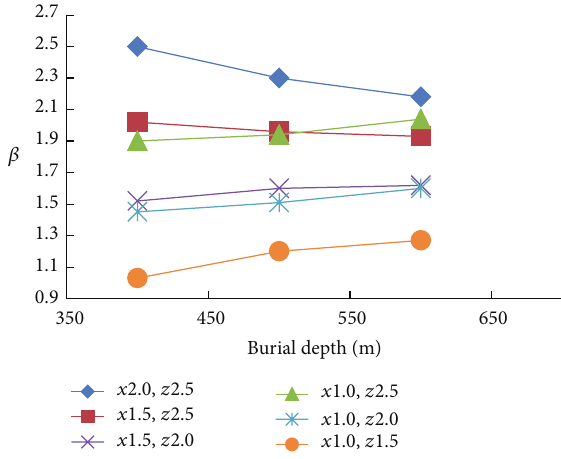
Figure 11: 𝛽 versus burial depth under varying lateral pressure coefficient.